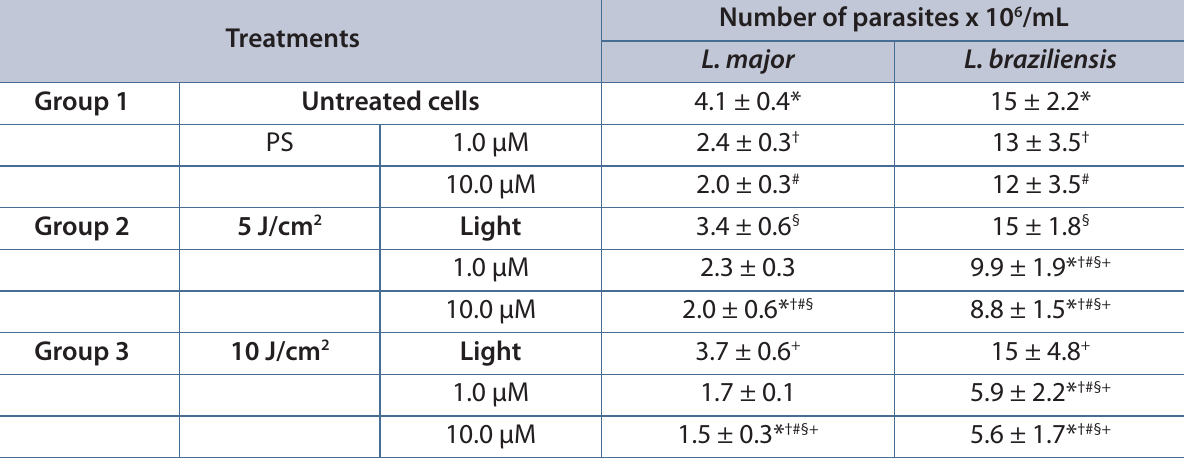
Table 1. Comparative results for Leishmania major and Leishmania braziliensis promastigotes growth after PDT with AlPcS 4